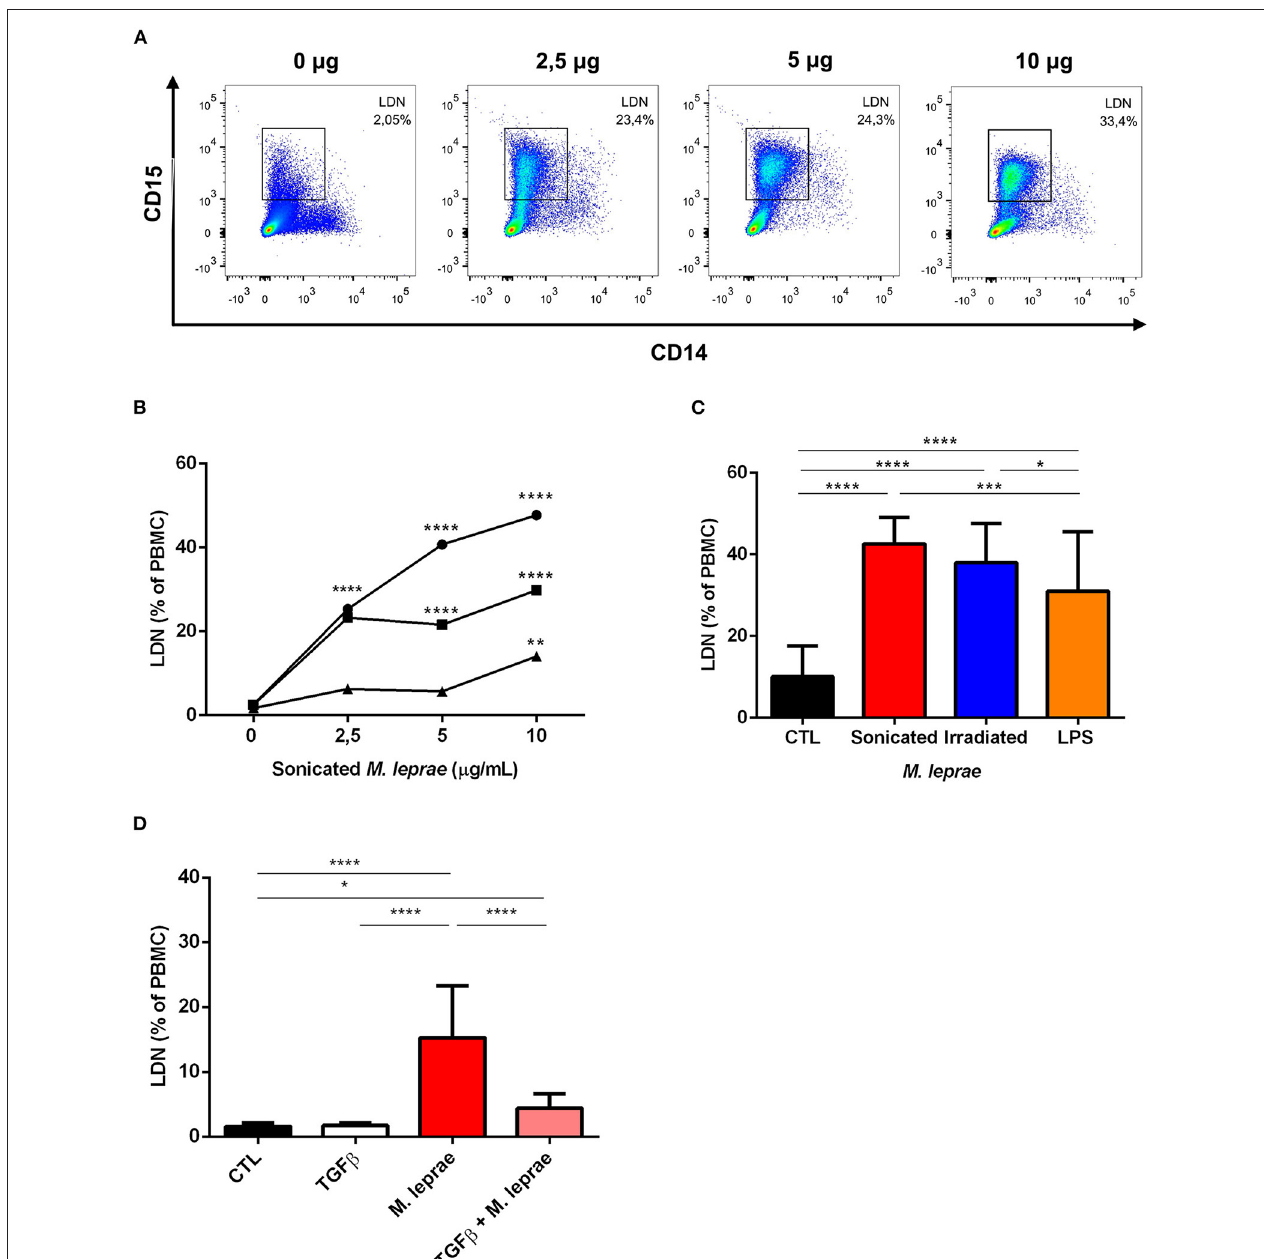
FIGURE 5 | M. leprae induces low-density neutrophilic generation in vitro . (A) Representative FACS analysis of a whole blood sample of a health donor. The sample was stimulated with 0, 2.5, 5, and 10 µ g/mL of sonicated M. leprae ( n = 3). After 24h of incubation, the culture cells were submitted to density centrifugation and the PBMC layer was analyzed by flow cytometry to identify CD14 − CD15 + LDN. (B) LDNs frequency in healthy-donor whole blood cultures stimulated or not with sonicated M. leprae at different concentrations (2.5, 5, and 10 µ g/mL) for 24h incubation ( n = 3). (C) Frequency of LDNs in peripheral blood of healthy individuals stimulated with 10 µ g/mL of sonicated or irradiated M. leprae and 100ng/mL of LPS ( n = 3). (D) Frequency of LDNs in the peripheral blood of healthy individuals stimulated with TGF β 1 at 10ng/mL alone or in combination with 10 µ g/mL of sonicated M. leprae ( n = 3). All experiments were carried out in triplicate. Statistics: two-way ANOVA with Sidak’s post-test. * p < 0.05, ** p < 0.01, *** p < 0.001, and **** p < 0.0001.